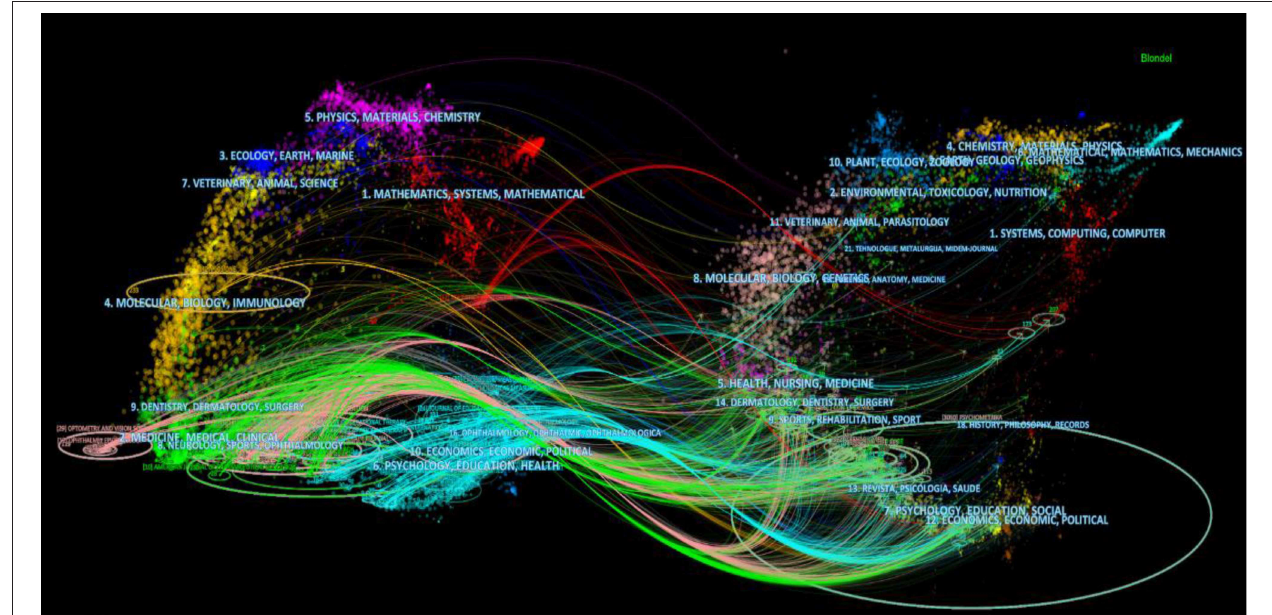
FIGURE 2 | The dual-map overlay of the Rasch measurement specialty generated by CiteSpace (Chen, 2016a).